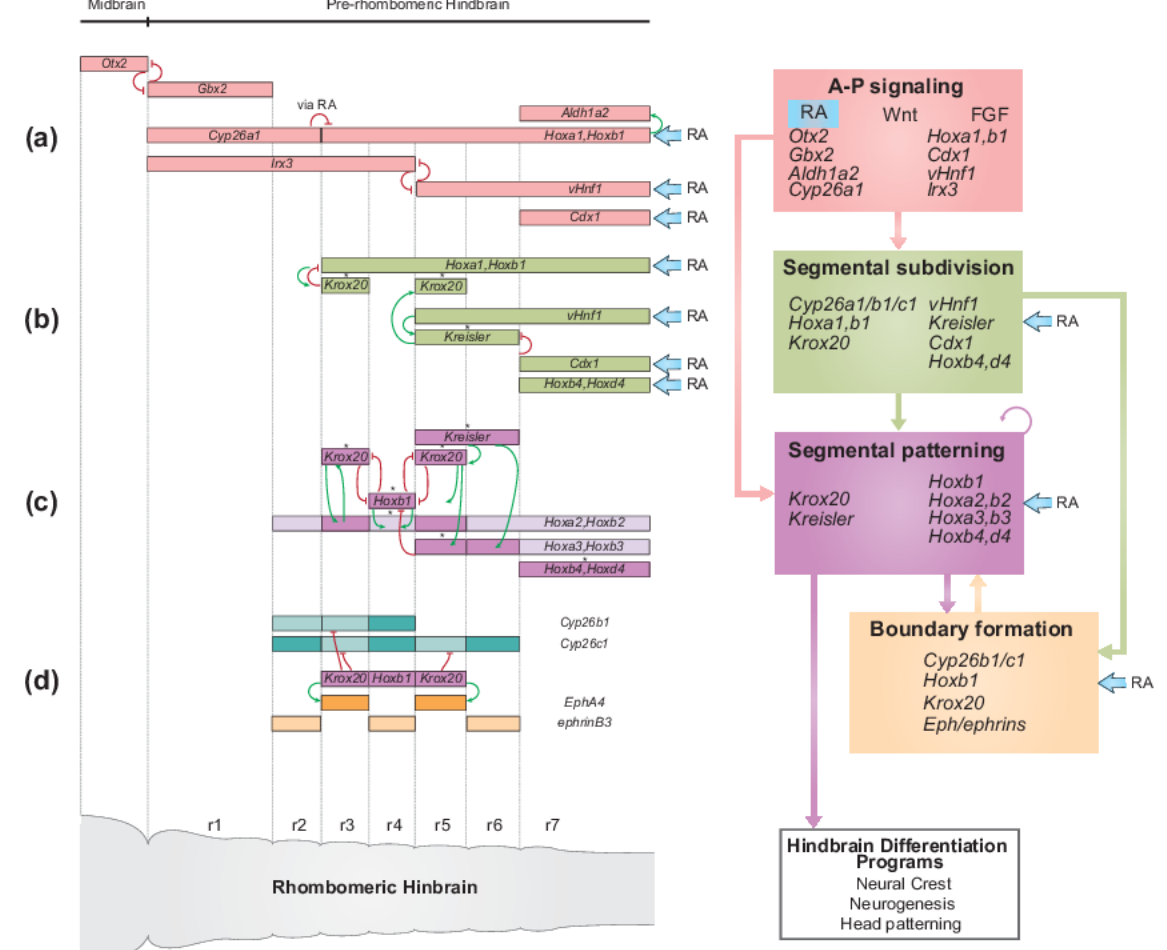
Figure 3. Regulatory interactions underlying the GRN for hindbrain segmentation. Diagram depicting regulatory interactions between major components of the GRN for hindbrain segmentation. ( a ) The A-P signaling module (pink box), defined by major signaling pathways (FGF, RA, Wnt) and their initial A-P patterning target genes, initiate the process of segmentation. The spatial organization of these transcription factor (TFs)-encoding genes (e.g., Otx2 , Gbx2 , Irx3 ) and their regulatory interactions (red and green arrows signify negative and positive regulatory interaction respectively) define the future hindbrain territory. RA, in association with key genes of the RA machinery ( Aldh1a2 , Cyp26a1 ), is also part of this module and plays a particularly important initial role in the hindbrain GRN by triggering the expression of many of the A-P genes (e.g., HoxPG1 , vHnf1 , Cdx1 ) (blue arrows). ( b ) In the segmental subdivision module (lime green box), RA will maintain the expression of many of these same genes, that together with additional important TF-encoding patterning genes ( Krox20 , Kreisler ) will subdivide the hindbrain into nested territories prefiguring future rhombomeric expression domains. This process is tightly controlled by additional mechanisms of cross-repression, activation, and autoregulation (*). ( c ) In the segmental patterning module (purple box), further regulatory interactions between different patterning genes will set up and maintain the segmental Hox code, important for dictating hindbrain differentiation programs. RA maintains an important role in this module. ( d ) In the boundary formation module (orange box), members of different modules ( Krox20, Hoxb1 ) together with Eph/ephrin , coordinate the establishment and maintenance of sharp boundaries between adjacent rhombomeres. Importantly, the segmental expression of Cyp26b1 and Cyp26c1 allows RA to modulate this module. Colored arrows indicate the regulatory interactions between different modules. Gene names are based on mouse and zebrafish models. Adapted from [43] .